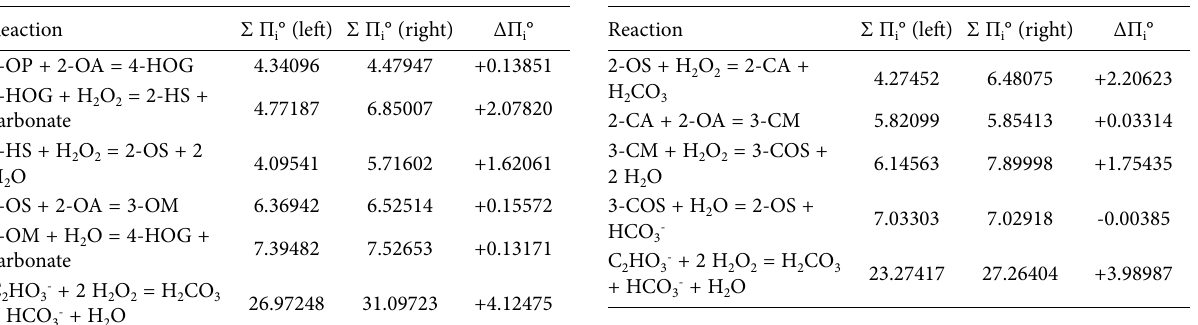
Table 7. Thermodynamic analysis of the malonate cycle represented at the top of figure 2. Such a cycle consume one glyoxylate molecule that is oxidized into carbon dioxide and water with an overall large- ly positive increase in entropy. All values are given at pH = 7 and I = 0.25 M and reported in zJ·K -1